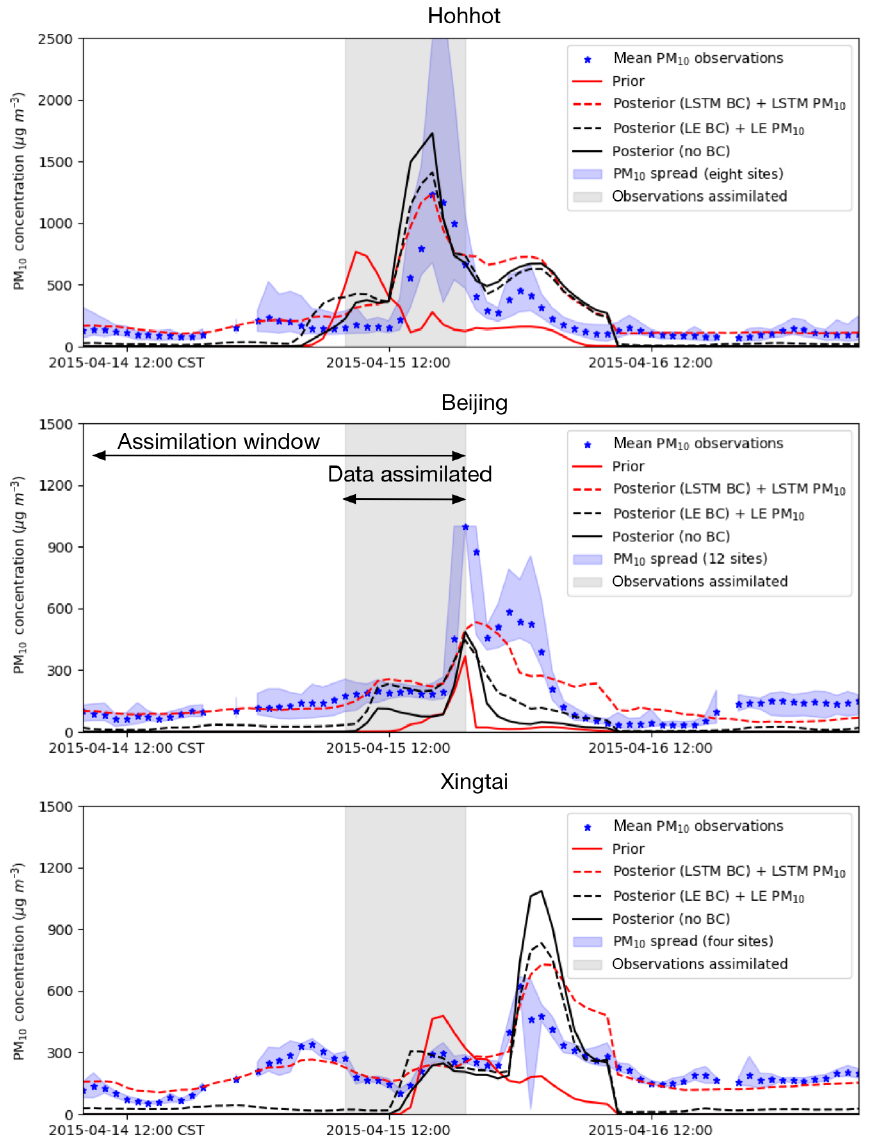
Figure 9. Time series of a posteriori dust concentration and PM 10 observations in three cities: Hohhot, Beijing, Xingtai (observations in the gray shaded part are